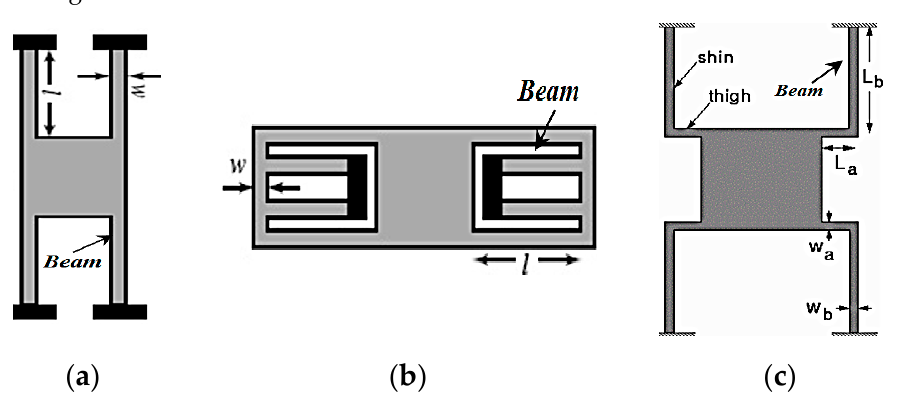
Figure 4. The electric field distribution’s ( a ) overall structure and ( b ) a focus showing a clearer Figure 1. The common MEMS spring geometries: ( a ) fixed–fixed flexures, ( b ) folded flexures, and view. ( c ) crab leg